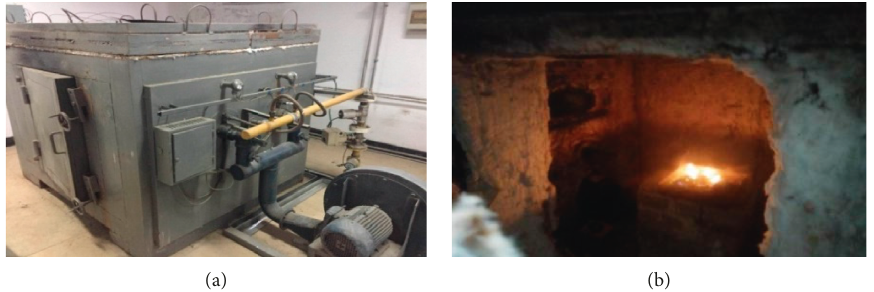
Figure 1: Combustion furnace and test process.